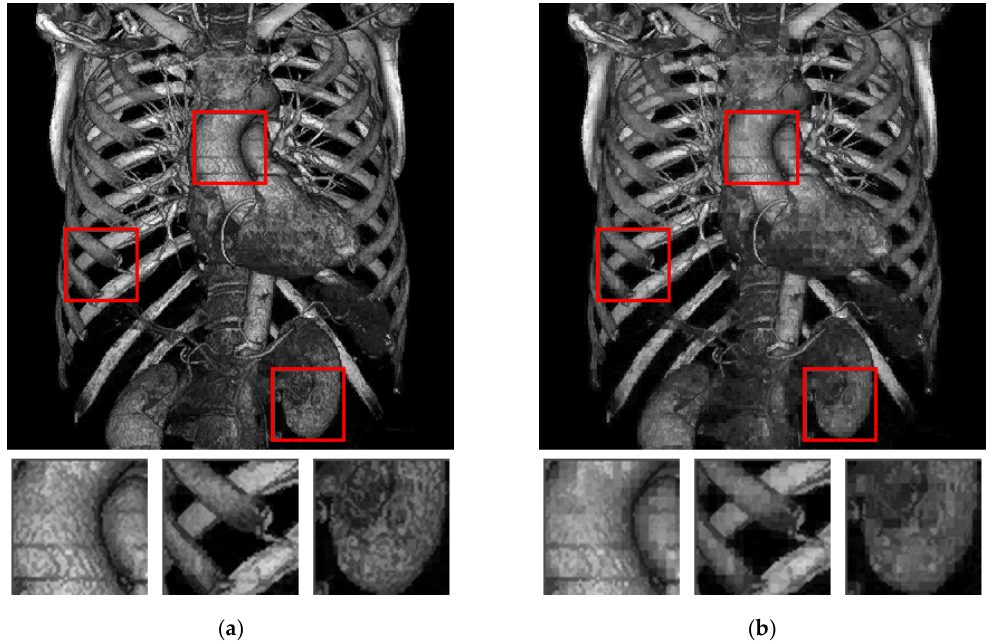
Figure 12. The difference of whether using the inter-block embedding scheme. ( a ) Result of using both intra- and inter-block embedding schemes. ( b ) Result of using only the intra-block embedding scheme.